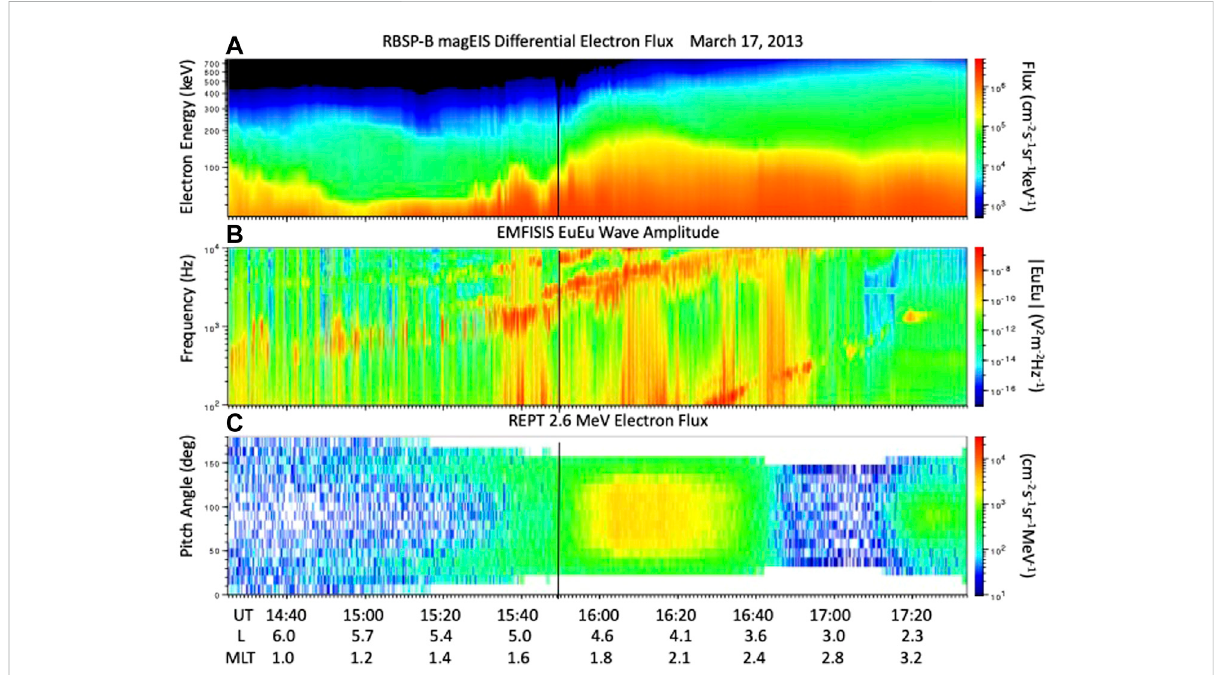
FIGURE 2 RBSP-B in situ observations following the format of Figure 1. The black line marks the spacecraft location (L ~4.8; 1.7 MLT)at 15:50 UT. RBSP-B observedpre-recoverybackgroundconditionsacrossL6to4.8asitprecededRBSP-Aby~1 h. (A) MagEISspectogramoflowerenergyelectron fl ux.